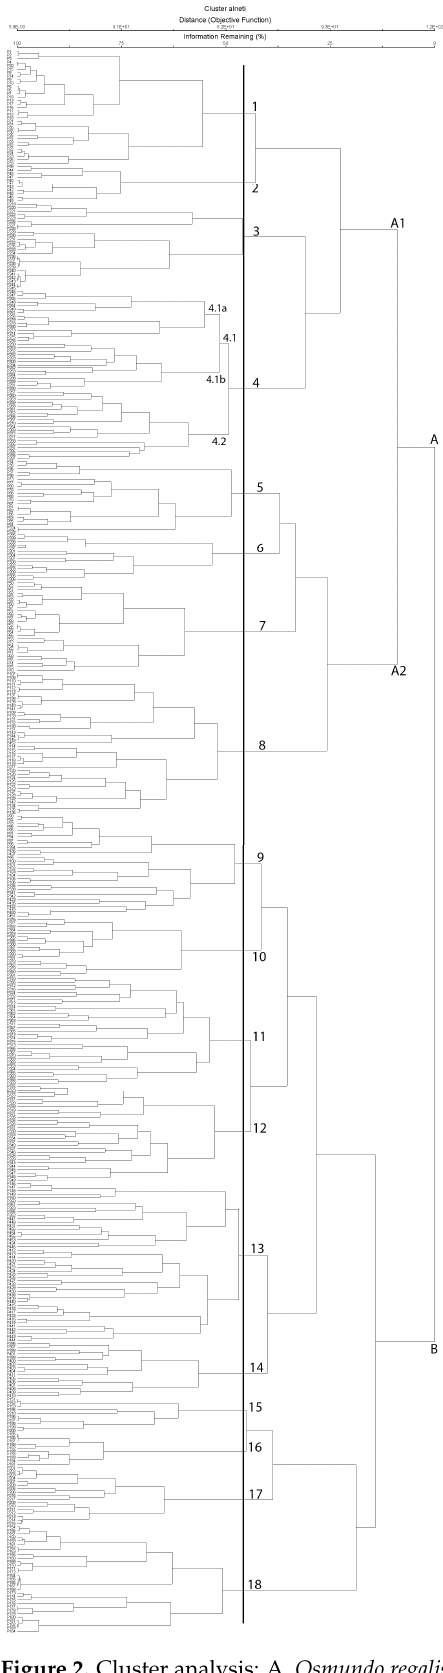
Figure 2. Cluster analysis: A. Osmundo regalis-Alnion glutinosae; B. Ligustro vulgaris-Alnion glutinosae. A1. Hyperico hircini–Alnenion glutinosae; A2 . Struthioptero-Alnenion glutinosae. Plant communities: 1 —